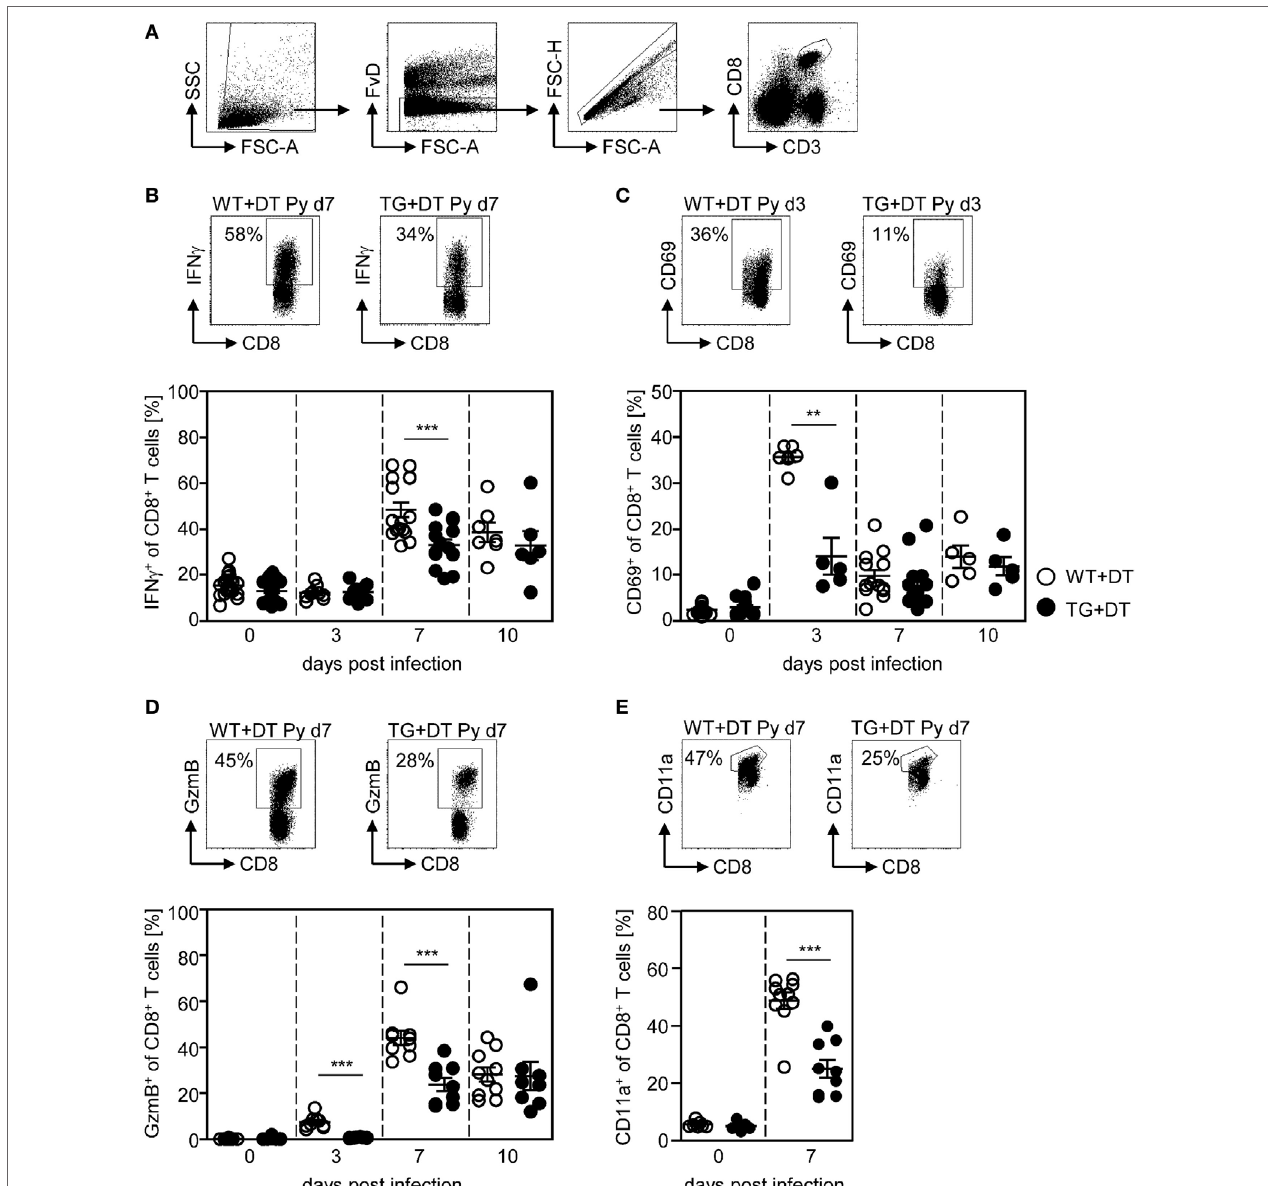
FigUre 2 | Impaired CD8 + T cell activation in CD11c high -depleted Plasmodium yoelii -infected mice. RosaiDTR/CD11c-cre (TG) and RosaiDTR wild-type (WT) mice were injected daily with diphtheria toxin (DT) ( + DT) starting 1 day prior to P. yoelii infection. At days 3, 7, and 10 post infection, splenocytes were isolated and